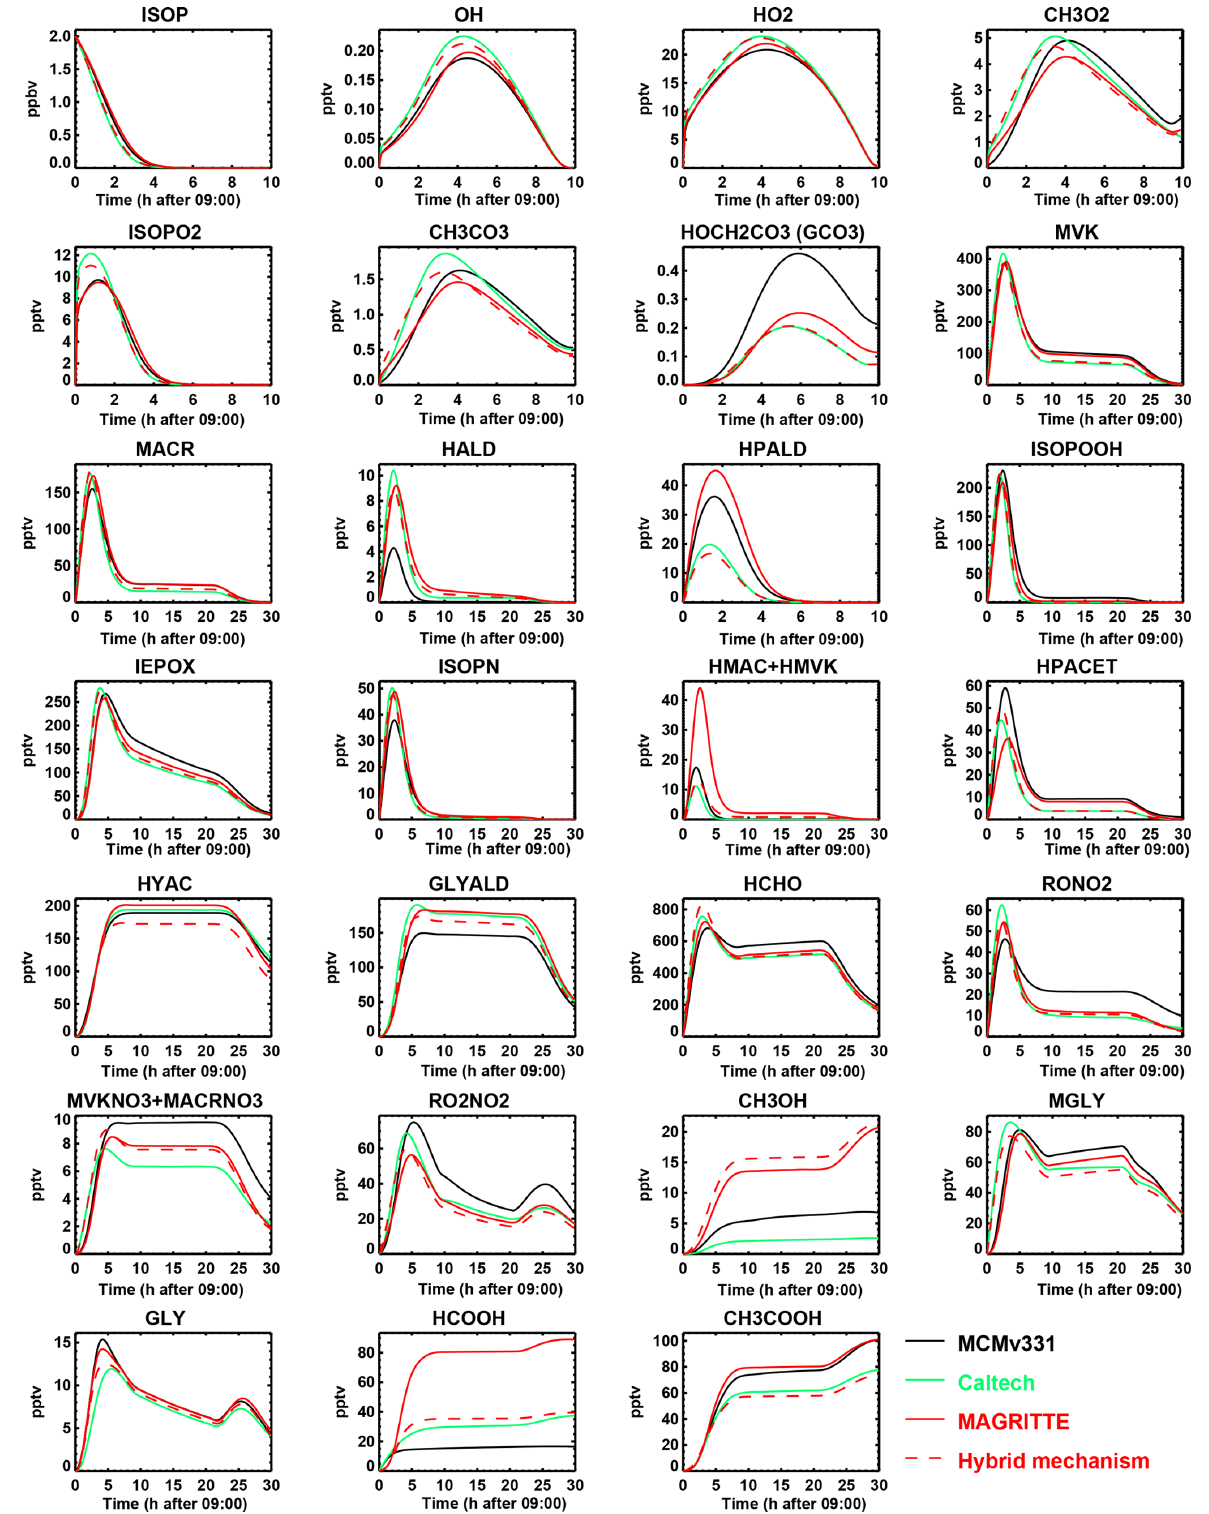
Figure 5. As Fig. 4, for 100ppt NO x . The dashed red line corresponds to a simulation using the MAGRITTE mechanism with the Caltech representation of the isoprene peroxy 1,6 H-shift and of the hydroperoxycarbonyl photolysis reactions.